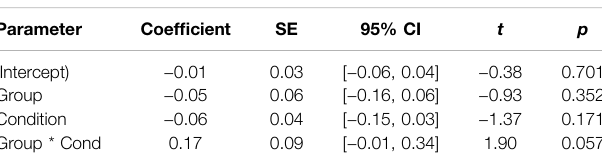
TABLE 3 | Results of linear mixed model